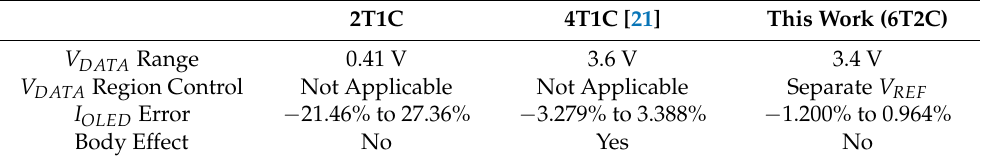
Figure 7. OLED currents and current errors over gray data. ( a ) 2T1C circuit. ( b ) 4T1C circuit. ( c ) Proposed 6T2C circuit. Table 2. Performance summary and comparison. All pixel circuits have been designed with PMOS transistors of 0.4 µ m/0.65 µ m and re-simulated with the same SPICE model